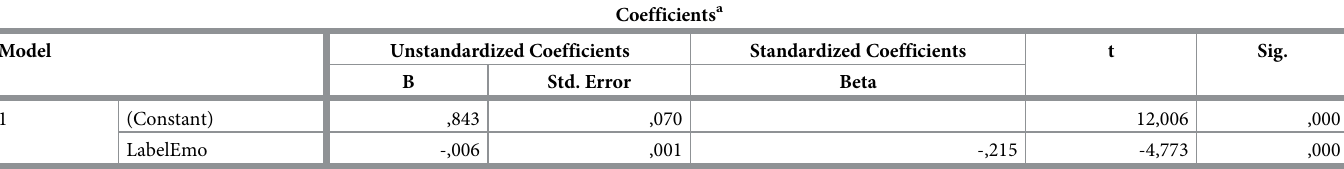
Table 4. Linear regression between test anxiety and performance.